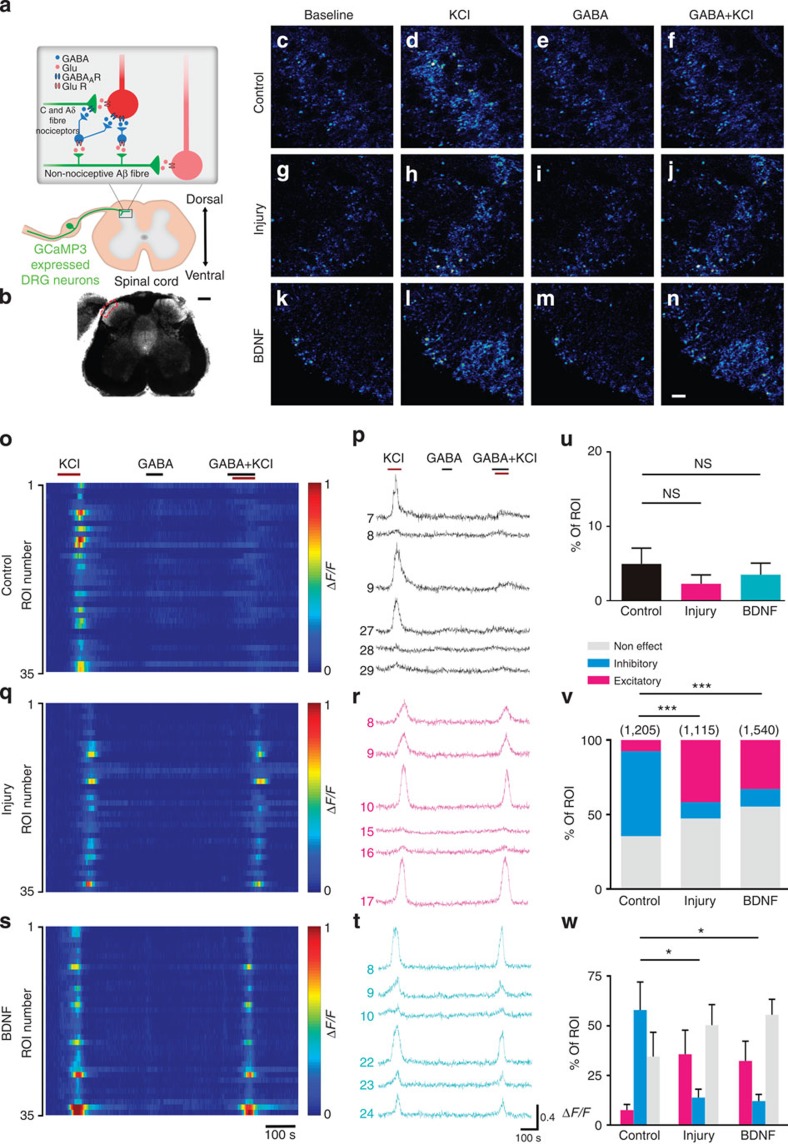
Two-photon calcium imaging in primary afferent terminals.(a) Scheme illustrating the specific expression pattern of GCaMP3 in primary sensory neurons. (b) Bright-field picture of spinal cord slice used for two-photon imaging. (c–n) Two-photon images from control, injured and BDNF-treated mouse spinal cord slice were showed in first (c–f), second (g–j) and third row (k–n), respectively. (o,q,s) Relative GCaMP3 fluorescence changes (ΔF/F) during high KCl, GABA alone and GABA+KCl in afferent terminals are shown as colour maps. (p,r,t) Traces showing the relative change of GCaMP3 fluorescence during high KCl, GABA and GABA+KCl in example ROIs from control (p), injured (r) and BDNF (t)-treated mouse spinal cord slice. (u) Fraction of ROIs responded to GABA application from separate experiments (control: n=4; injury, n=5; BDNF, n=6). Error bars indicate s.e.m. (v) and (w) Frequency histograms of the proportion of three different effects of GABA on high KCl-induced GCaMP3 fluorescence increase. (v) The proportion from all ROIs pooled from all experiments. The number of ROIs recorded is indicated in parentheses in each panel. (Control versus injury, χ2-test, P<0.0001; control versus BDNF, χ2-test, P<0.0001). Error bars indicate s.e.m. Error bars in w represents the s.e.m. of the proportion of ROIs from separate experiments (experiment number: control, n=5; injury, n=6; BDNF, n=7; inhibitory effect: control versus injury, unpaired t-test, P<0.05; control versus BDNF, unpaired t-test, P<0.05. excitatory effect: control versus injury, unpaired t-test, P>0.05; control versus BDNF, unpaired t-test, P>0.05). Scale bars, (b) 200 μm; (c–n) 10 μm; (scale bar only shown in b and n). *P<0.05; ***P<0.001.